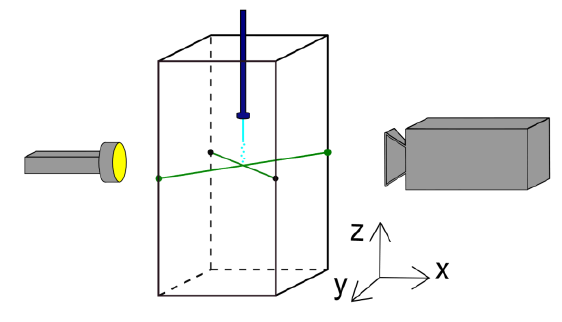
Fig. 5. Experimental setup .